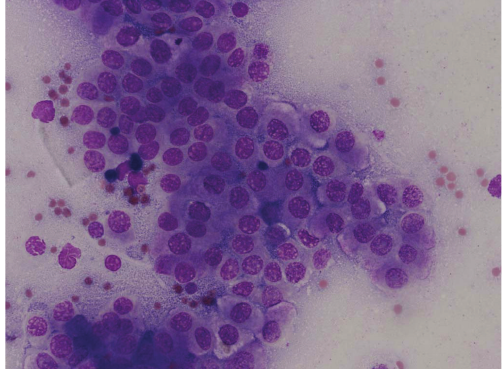
Figure 2: Initial cytology of nasal mass with large cluster of round to polygonal epithelial cells, Wright-Geimsa stain, 50x objective.